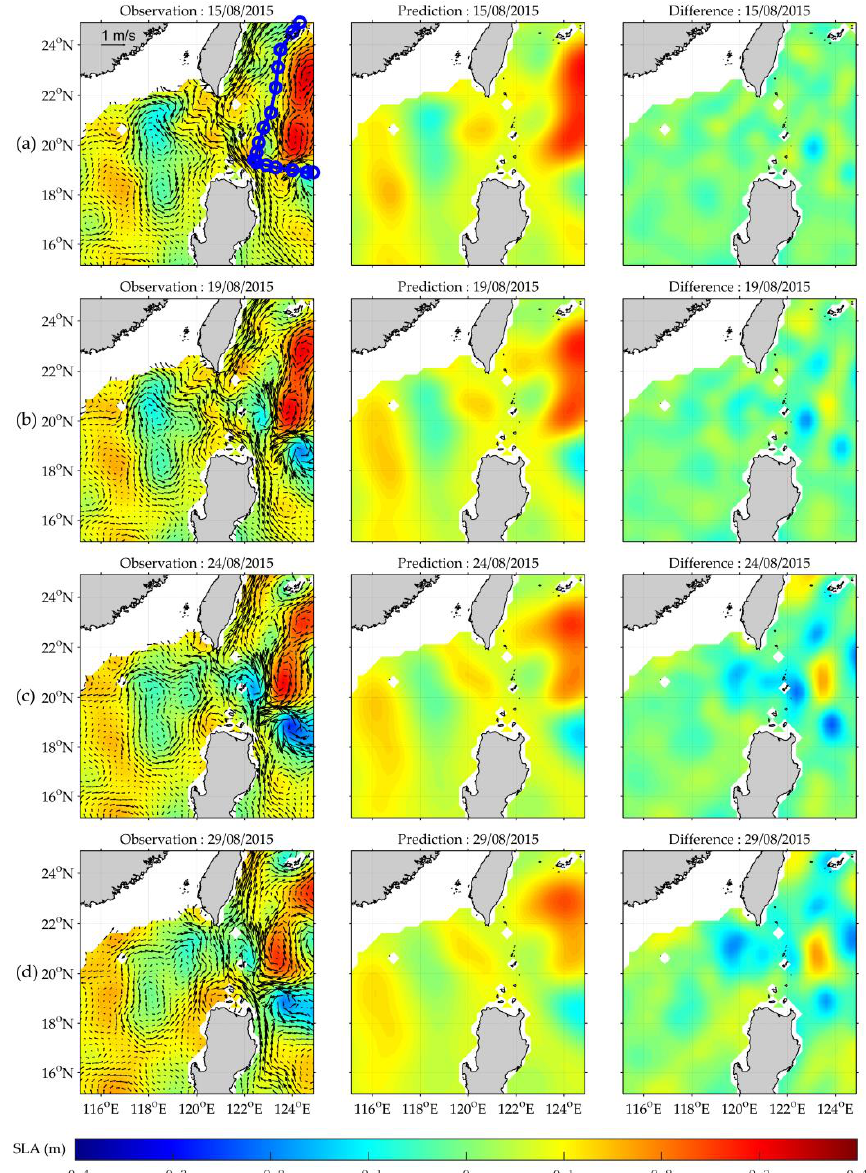
Figure 16. Comparison between observed and predicted SLA at ( a ) day 1, ( b ) day 5, ( c ) day 10, ( d ) day 15. The left column shows the results from observation, the middle column shows the results from the prediction, and the right column shows the difference between the observed and predicted SLA . Black vectors are the variation of geostrophic current. Blue line is track of Typhoon Goni from